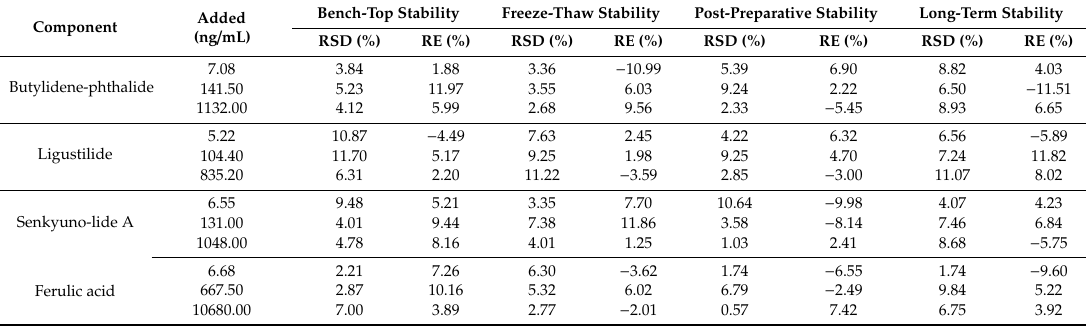
Table 3. Stability of butylidenephthalide, ligustilide, senkyunolide A and ferulic acid in rat plasma at di ff erent conditions ( n = 6).